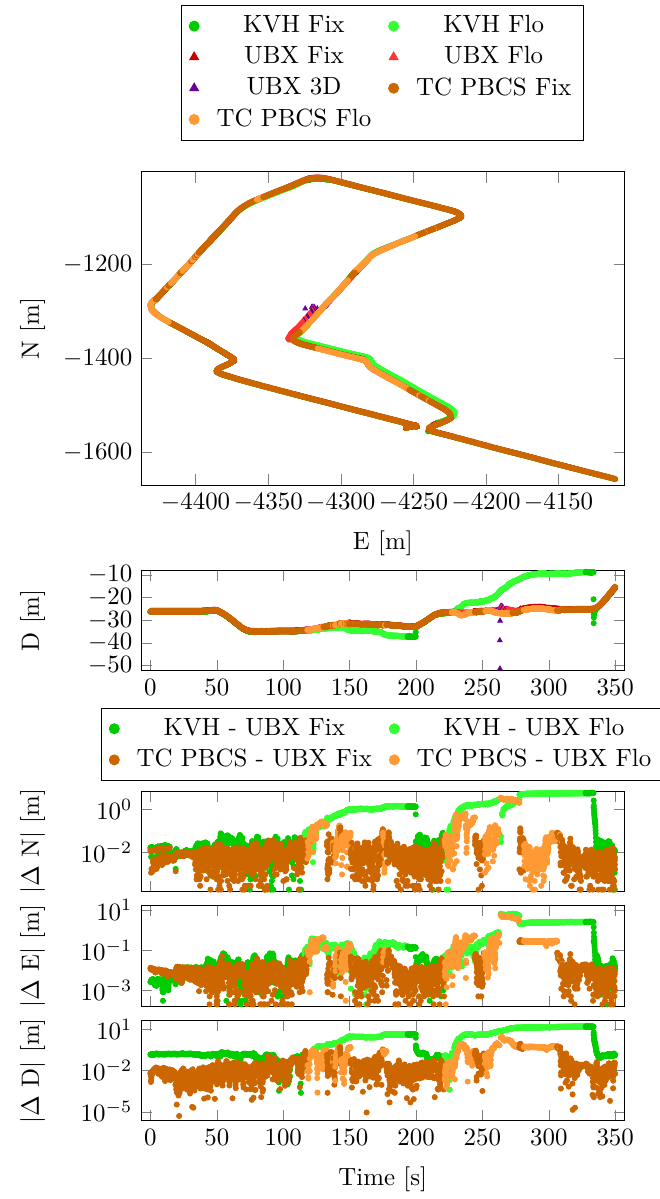
Figure 13. Position and position differences from the reference—Case Study